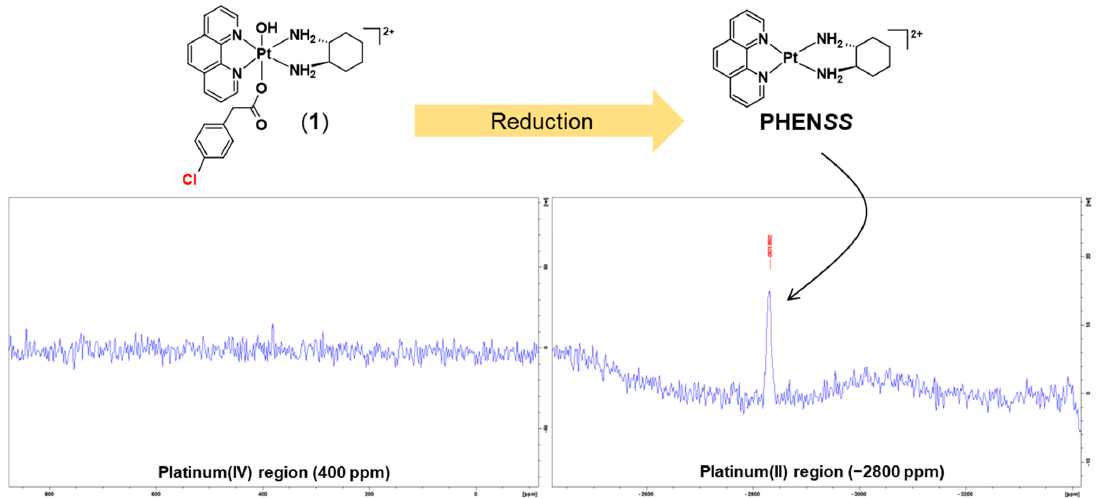
Figure 16. 1D − 195 Pt − NMR spectra of 1 with PBS and AsA in D 2 O, within the regions of − 2800 and 400 ppm at 37 °C, highlighting its complete reduction after 1 h after the final 1 H − NMR experiment.